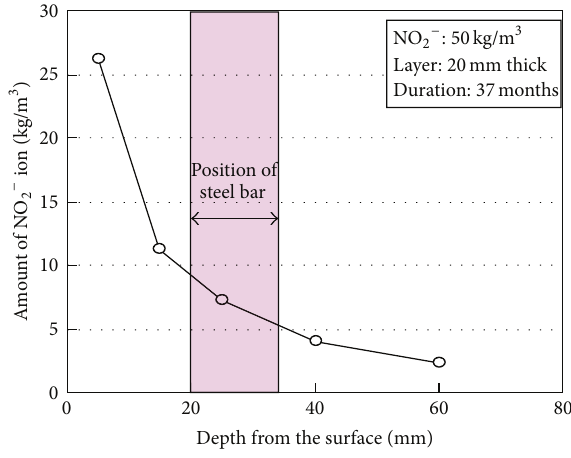
Figure 7: Distribution of NO 2− ion concentration in the concrete specimen attached with a thin mortar layer containing a large amount of LiNO 2 exposed to outdoor